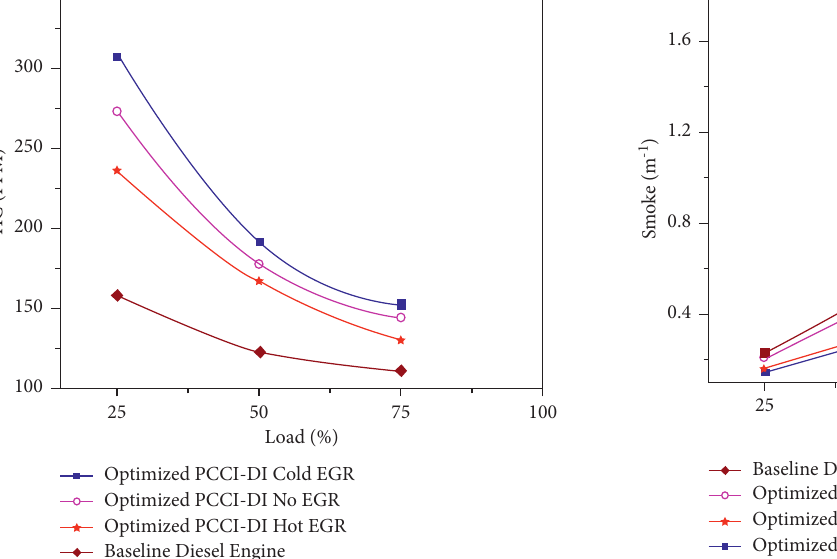
Figure 6: Effects of EGR configurations on smoke versus